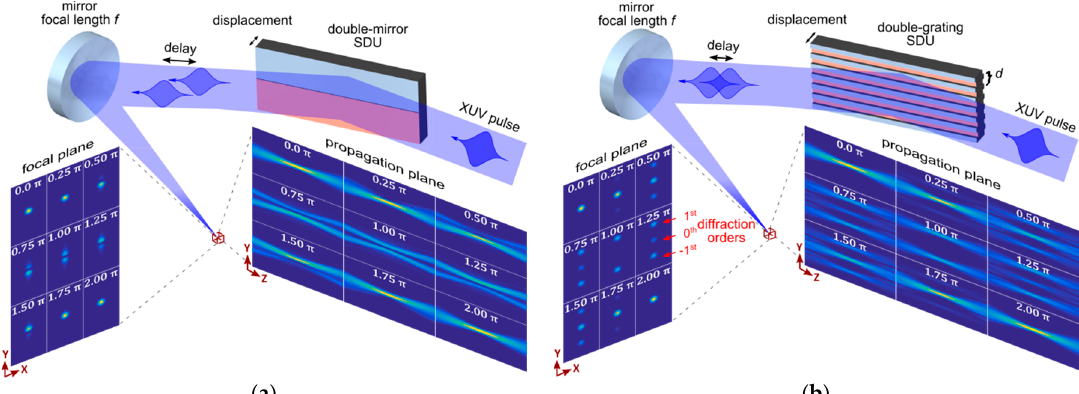
Figure 1. Comparison of a conventional double-mirror SDU ( a ) and a lamellar-grating SDU ( b ). The insets with blue background show simulated light intensity distributions in the focal (XY) and the propagation (YZ) planes for nine different phase delays ranging from 0 to 2π . ( a ) The double-mirror SDU generates two spatially separated beams which are superimposed by the focusing optics at a small angle with their wavefronts tilted in opposite directions. As a result, their relative phase varies continuously along the Y-axis. Hence, a detector with infinitely high resolution would be required to discriminate single interference states. ( b ) Each grating of the SDU diffracts the incident beam. Partial beams from the two gratings propagate collinearly in every diffraction order, which is justified by the complete destructive interference in the zeroth order for ∆ φ = π . Spatial selection of a single order for detection allows for high-contrast interferometric measurement.